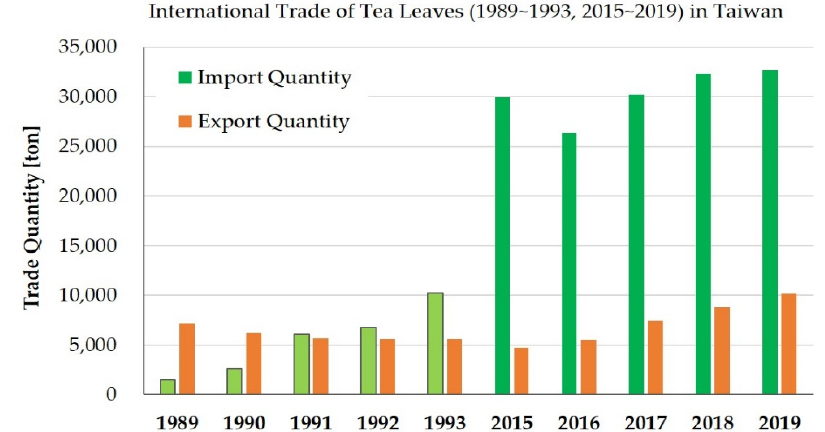
Figure 2. Comparison of import and export trade quantities of Taiwan’s tea-related products in the periods 1989~1993 and 2015~2019. The import and export data were sourced from the agricultural statistics website (accessed on 15 August 2020) of the Council of Agriculture in Taiwan.